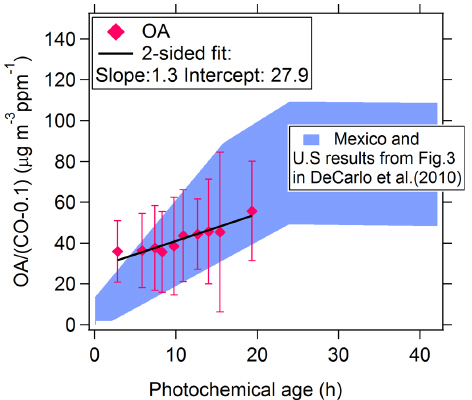
Fig. 12. OA/ 1 CO ratios as a function of photochemical age dur- ing the Changdao campaign. The photochemical age is classified into 10 bins by decile of photochemical age. The averages and stan- dard deviation in each photochemical age bin are also shown (pink diamonds and bars). The purple line is the linear regression results from the average values in each photochemical bin. The blue shaded areas are the SOA formation relationship with photochemical age determined in the US and Mexico City (DeCarlo et al.,